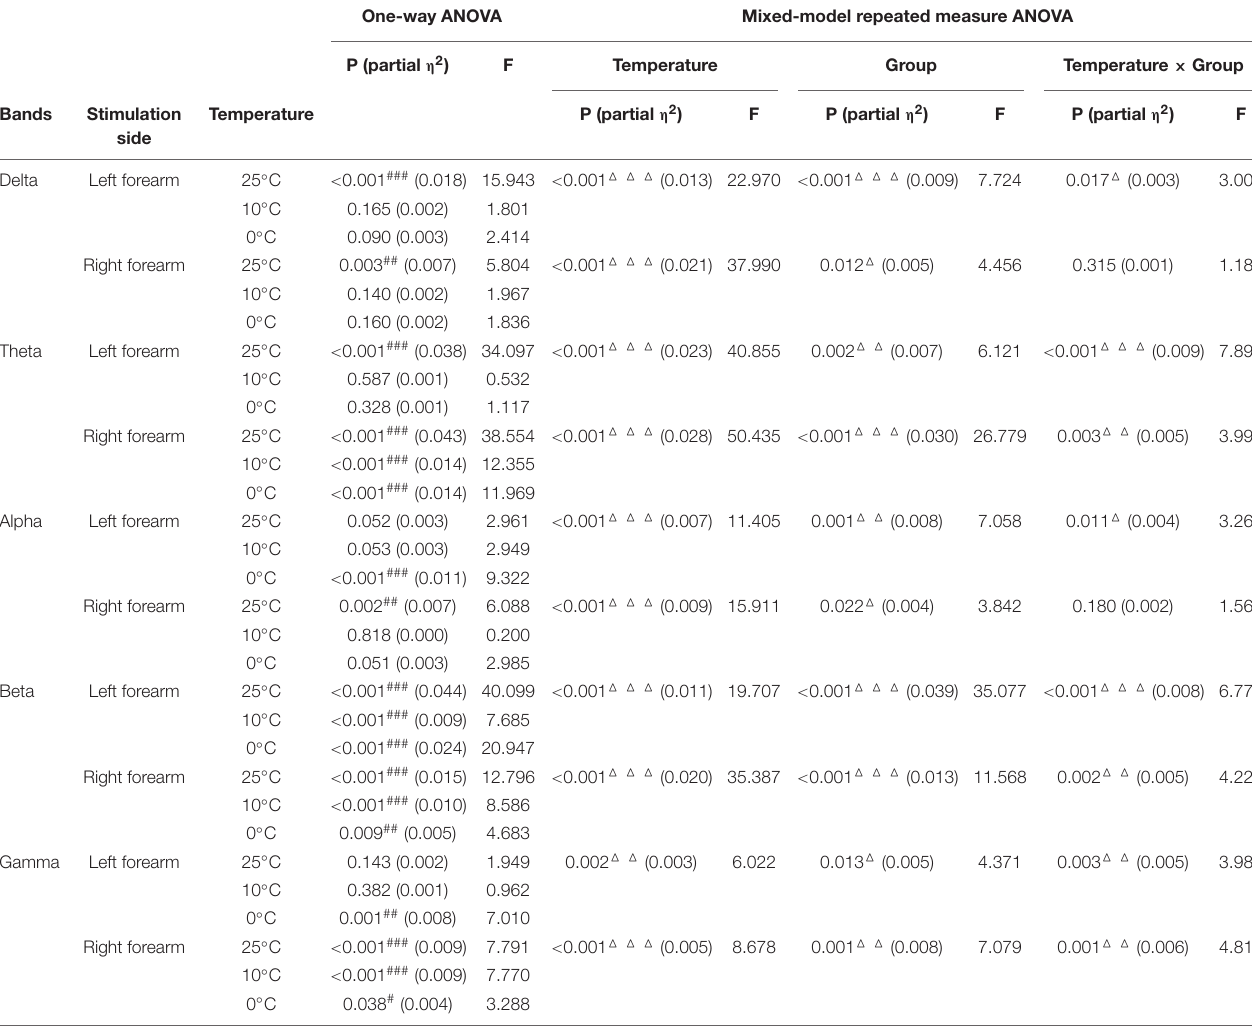
TABLE 4 | Intergroup comparisons on the whole brain relative spectral power of each EEG frequency band. One-way ANOVA Mixed-model repeated measure ANOVA